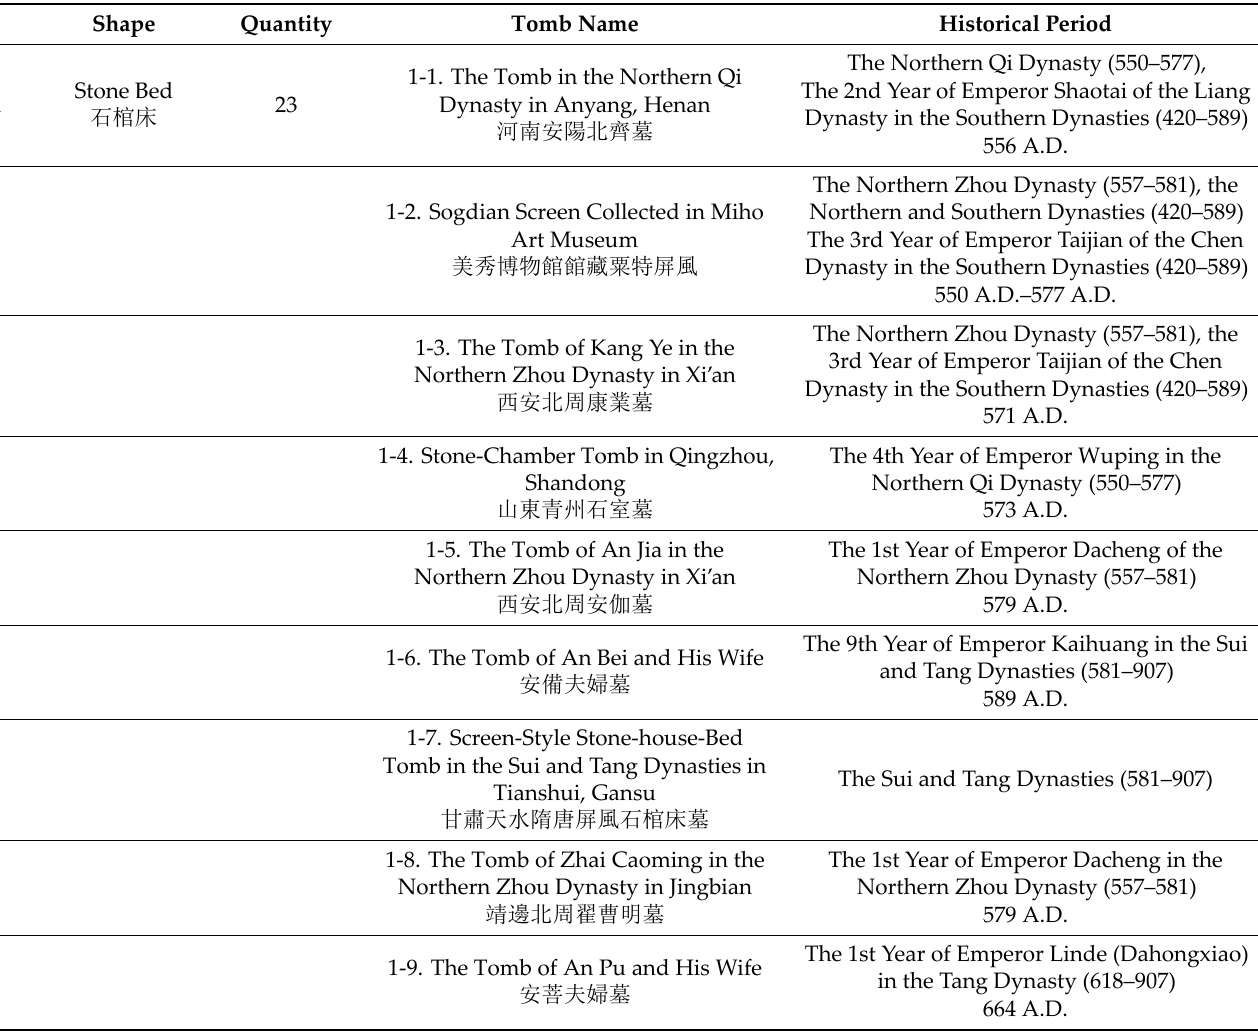
Table 2. The Distribution of the Shapes of Sogdian sarcophagi in